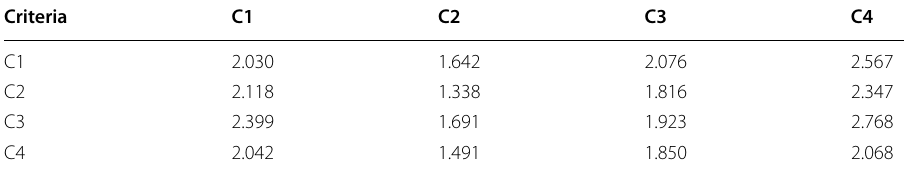
Table 19 Total relation matrix for the equity-based crowdfunding alternative Criteria